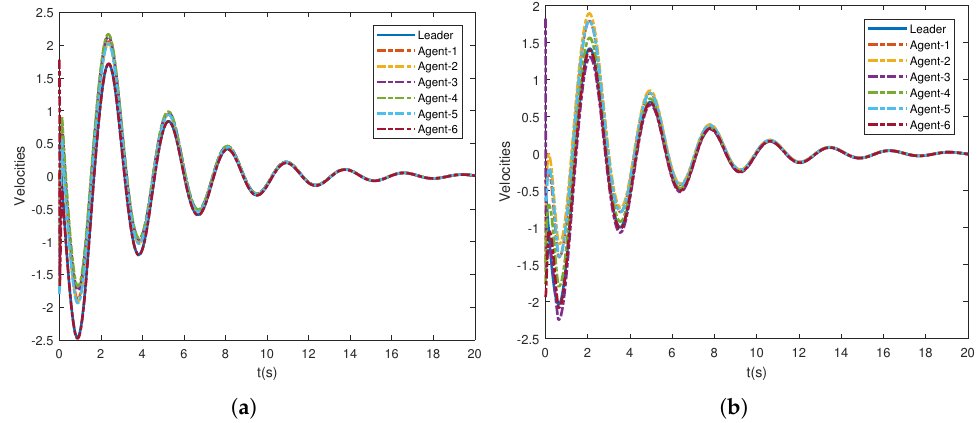
Figure 3. Consensus of velocities under different topologies. ( a ) Velocities of the leader and followers under G 1 ; ( b ) velocities of the leader and followers under G 2 .